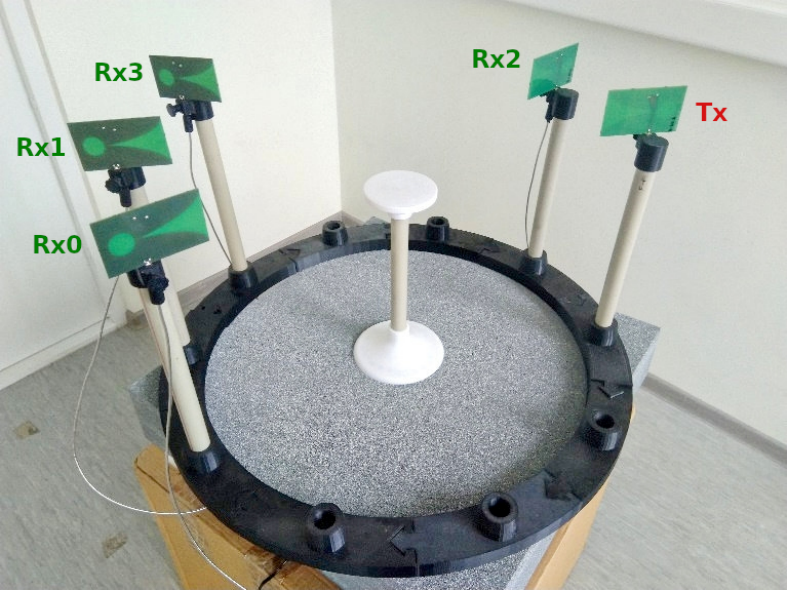
Figure 3. Multistatic UWB IR experimental measurements setup: Tx-transmitting antenna, from Rx0- to Rx3-receiving